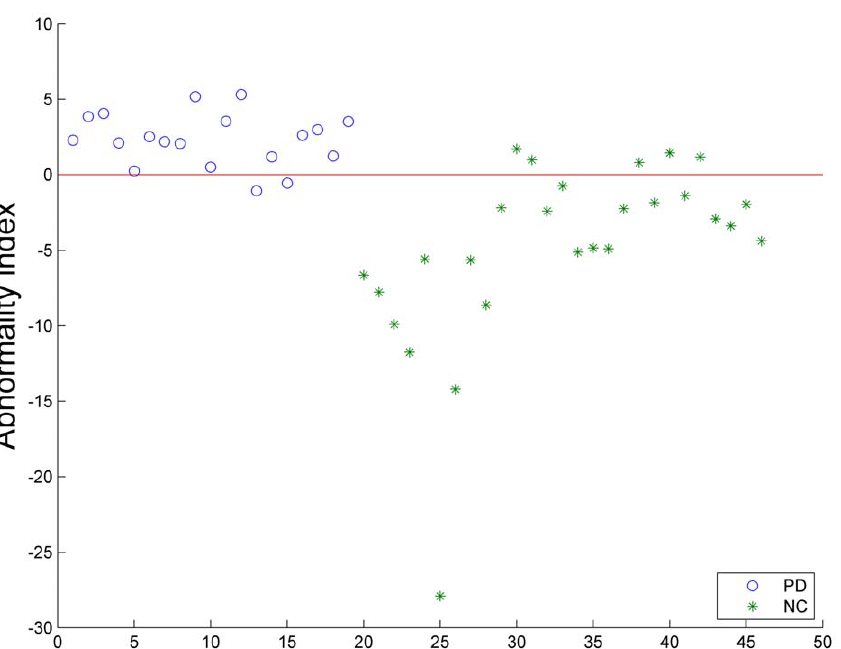
Figure 3. Scatter plot of the abnormality index-scores of all subjects. Positive scores represent subjects classified in the PD group and negative scores represent subjects classified in the NC group.